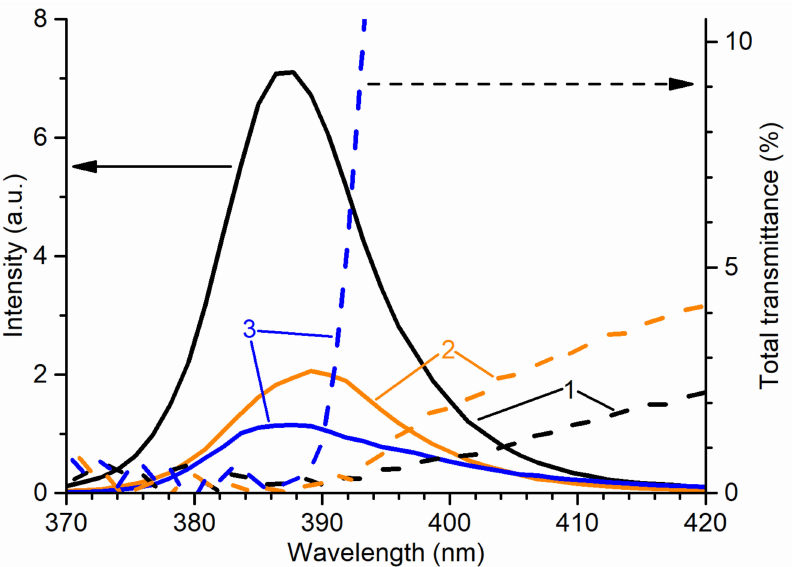
Figure 6. Normalized RL spectra and total transmittance spectra of 1—ZnO whiskers; 2—ZnO nanowalls; 3—ZnO:Ga ceramics at RT in the spectral range of NBE